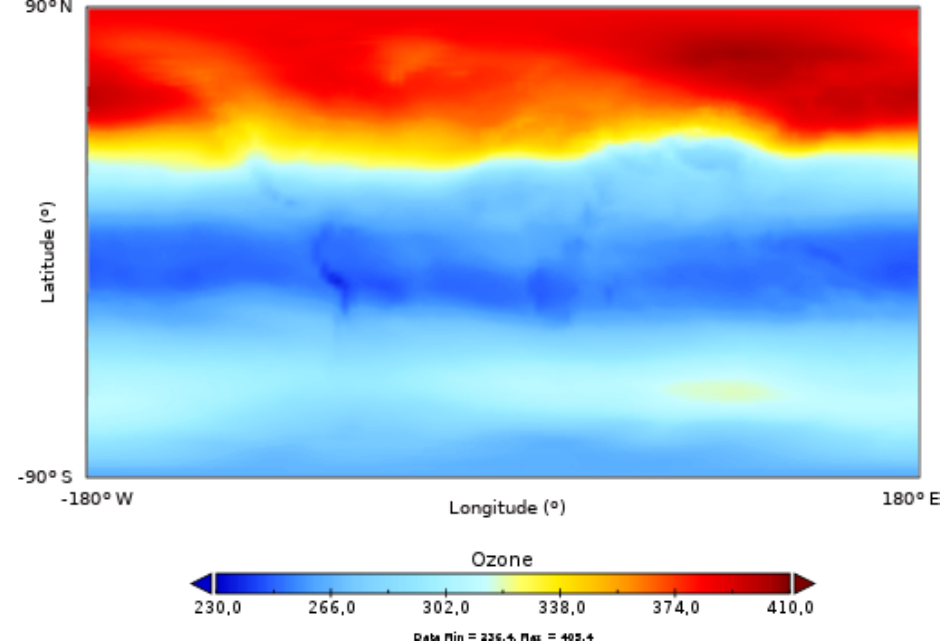
Figure 5. Climatology of O 3 (Dobson units) for the month of May. Data obtained from the multi-sensor reanalysis from GOME-2, OMI and SCIAMACHY sensors between 1978 and 2008.